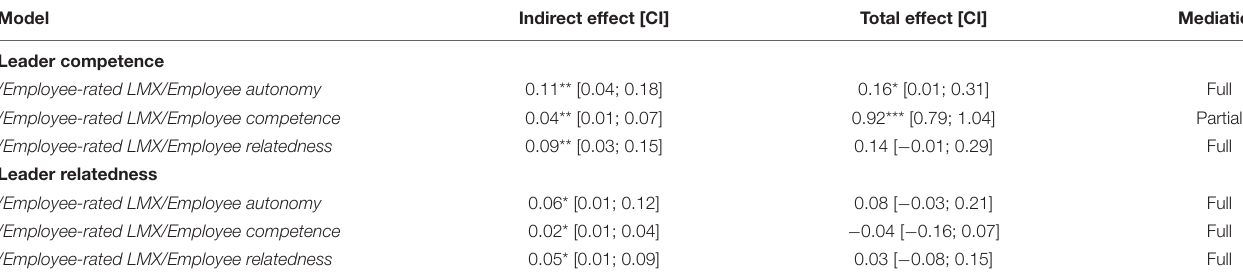
TABLE 6 | Monte Carlo mediation indirect effects per psychological need.